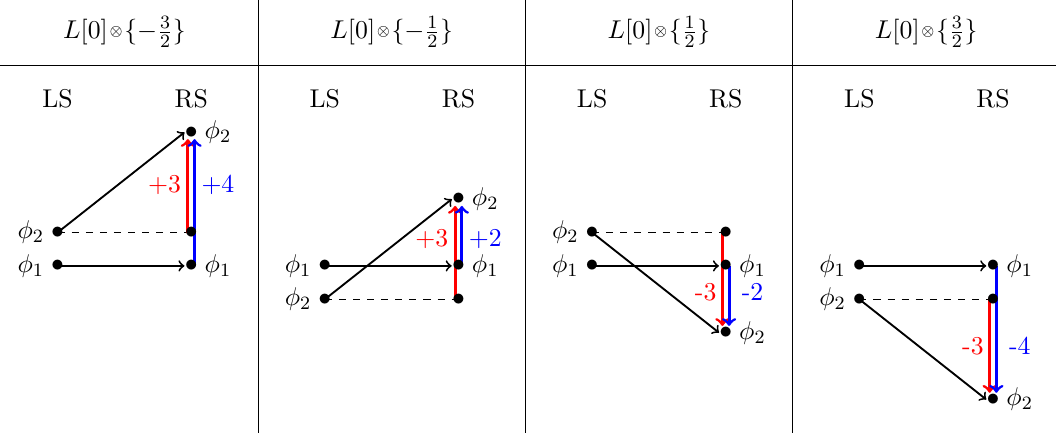
Figure 1 . Shift patterns of the conformal dimensions of the bosonic states within L [ 1 from the left- to the right-squashed S 7 .